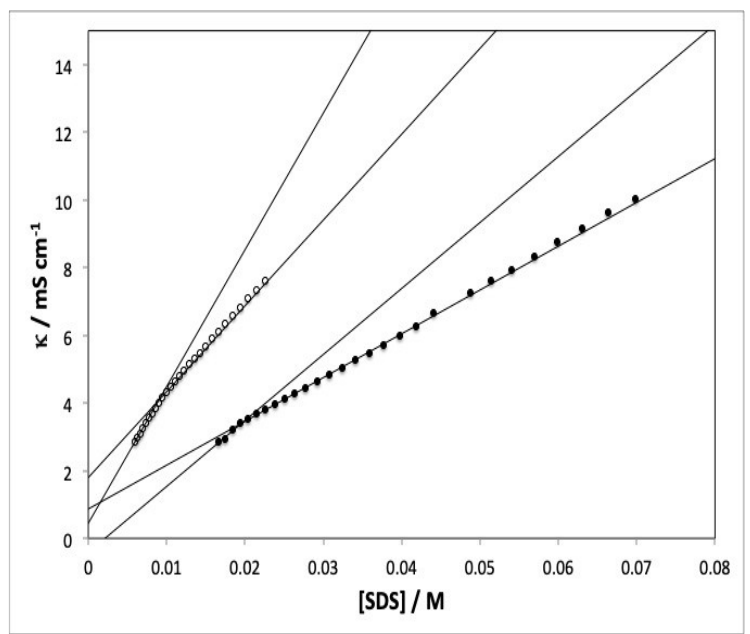
Figure 1. Typical specific conductance vs surfactant concentration plot for SDS in an aqueous colloid solution. [CA] = 3 × 10 − 4 M. Temperature: ( ) 25 ◦ C, ( ) 55 ◦ C. (cid:35) Table 1. CMC (mM kg − 1 ) and mean degree of micellization ( β ) in the SDS–CA micellar system at variable mole ratios as calculated from electrical conductivity plots. The uncertainly values are below 10%. [CA] × 10 − 5 mol kg −